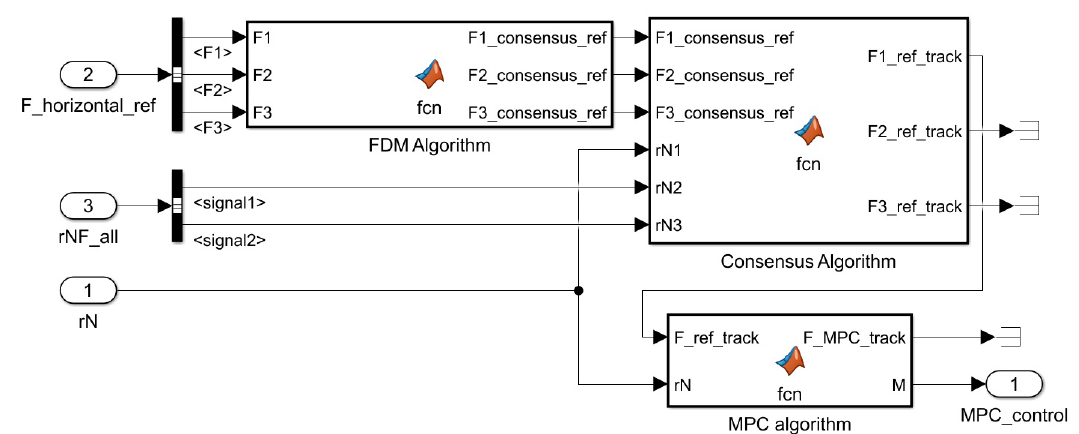
Figure 11. Configuration of follower’s horizontal motion